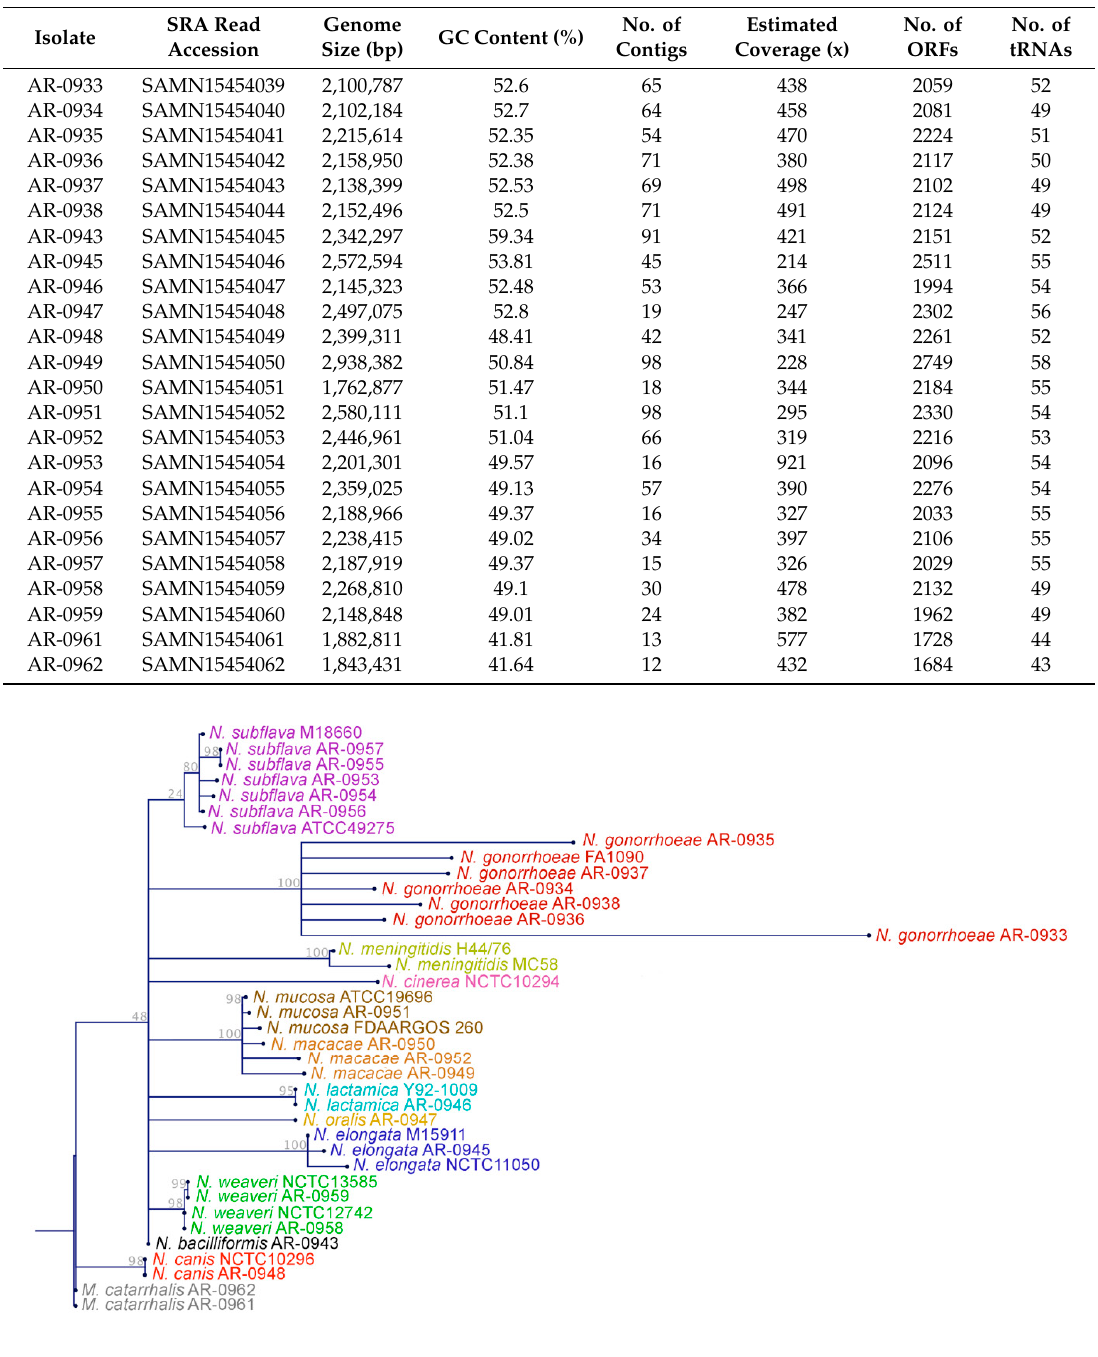
Table 2. Genome assembly statistics for sequenced strains.